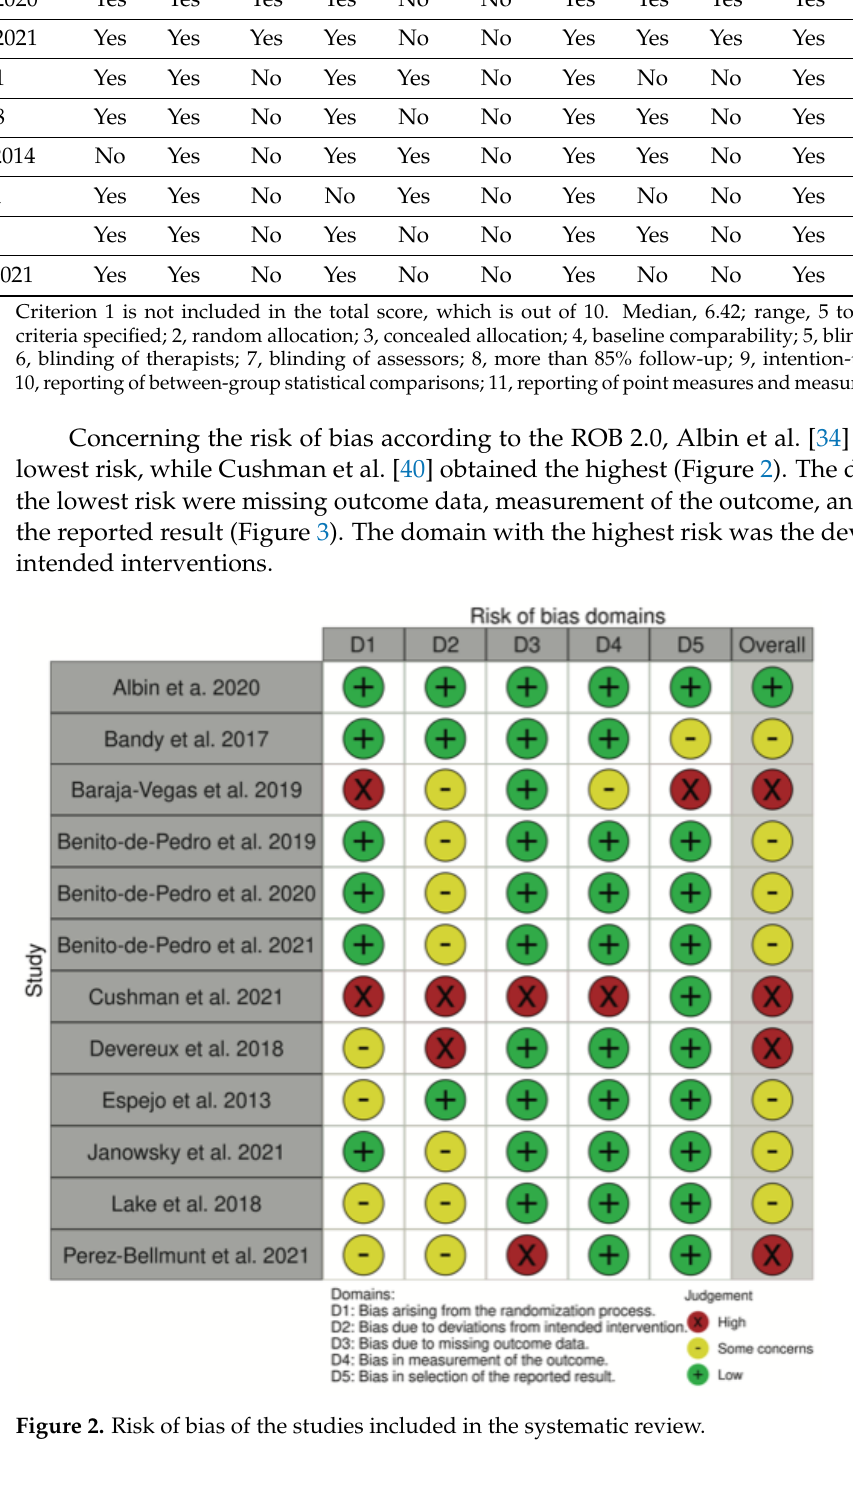
B i a s d ue t od e v i a t i o n s f r o m i n t en de d i n t e r v e n t i o n s Figure 3. Overall risk of bias, with each category presented as percentage. 3.3. Population Characteristics A total of 426 subjects were involved in the studies included in the systematic review, assuming that the studies carried out by De-Pedro et al. [37 – 39] involved the same partic- ipants. Albin et al. [34] is the study with the highest sample size, with 102 participants. Six studies included healthy non-athletic subjects [34 – 36,42,44,45], and the other six included athletes, all of them presenting MTrPs in the triceps surae muscles. From the studies in athletes, they practiced the following sports: triathlon [37 – 39], running [40], professional ballet dance [43], and any sport in which jumping, sprinting, twisting, turning, Overallriskofbias B i a s i n s e l e c t i ono ft he r epo r t ed r e s u l t B i a s i n m e a s u r e m e n t o ft he o u t c o m e B i a s due t o m i ss i ngou t c o m eda t a